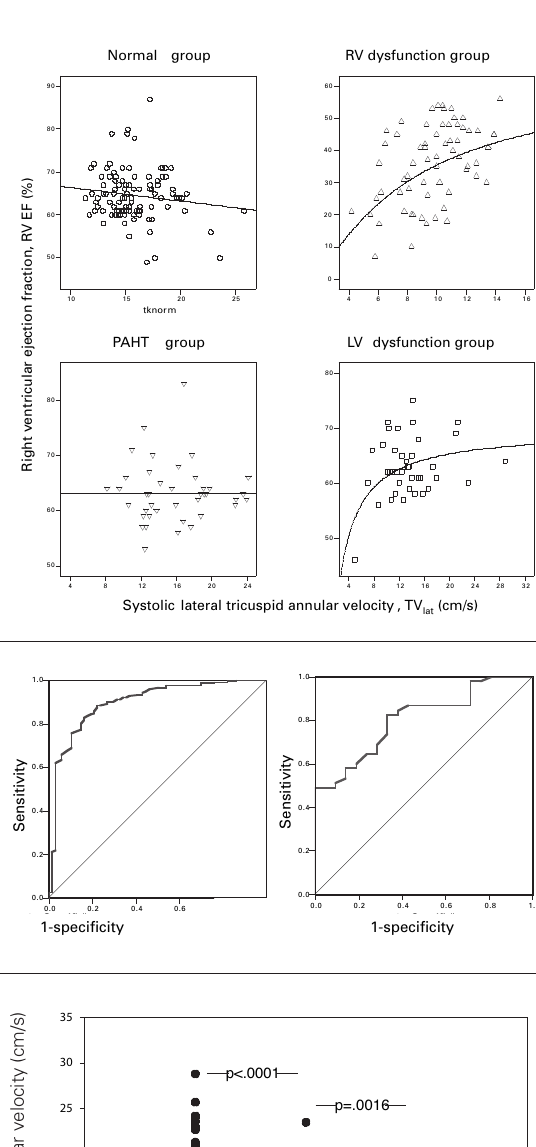
Systolic lateral tricuspid annular velocities (vertical axis) in tertile groups of right ventricular ejection fraction (RVEF; horizontal axis). Bar graphs indicate mean values and 75% confidence intervals, error bars show 90% confidence limits, and beyond those, individual values are